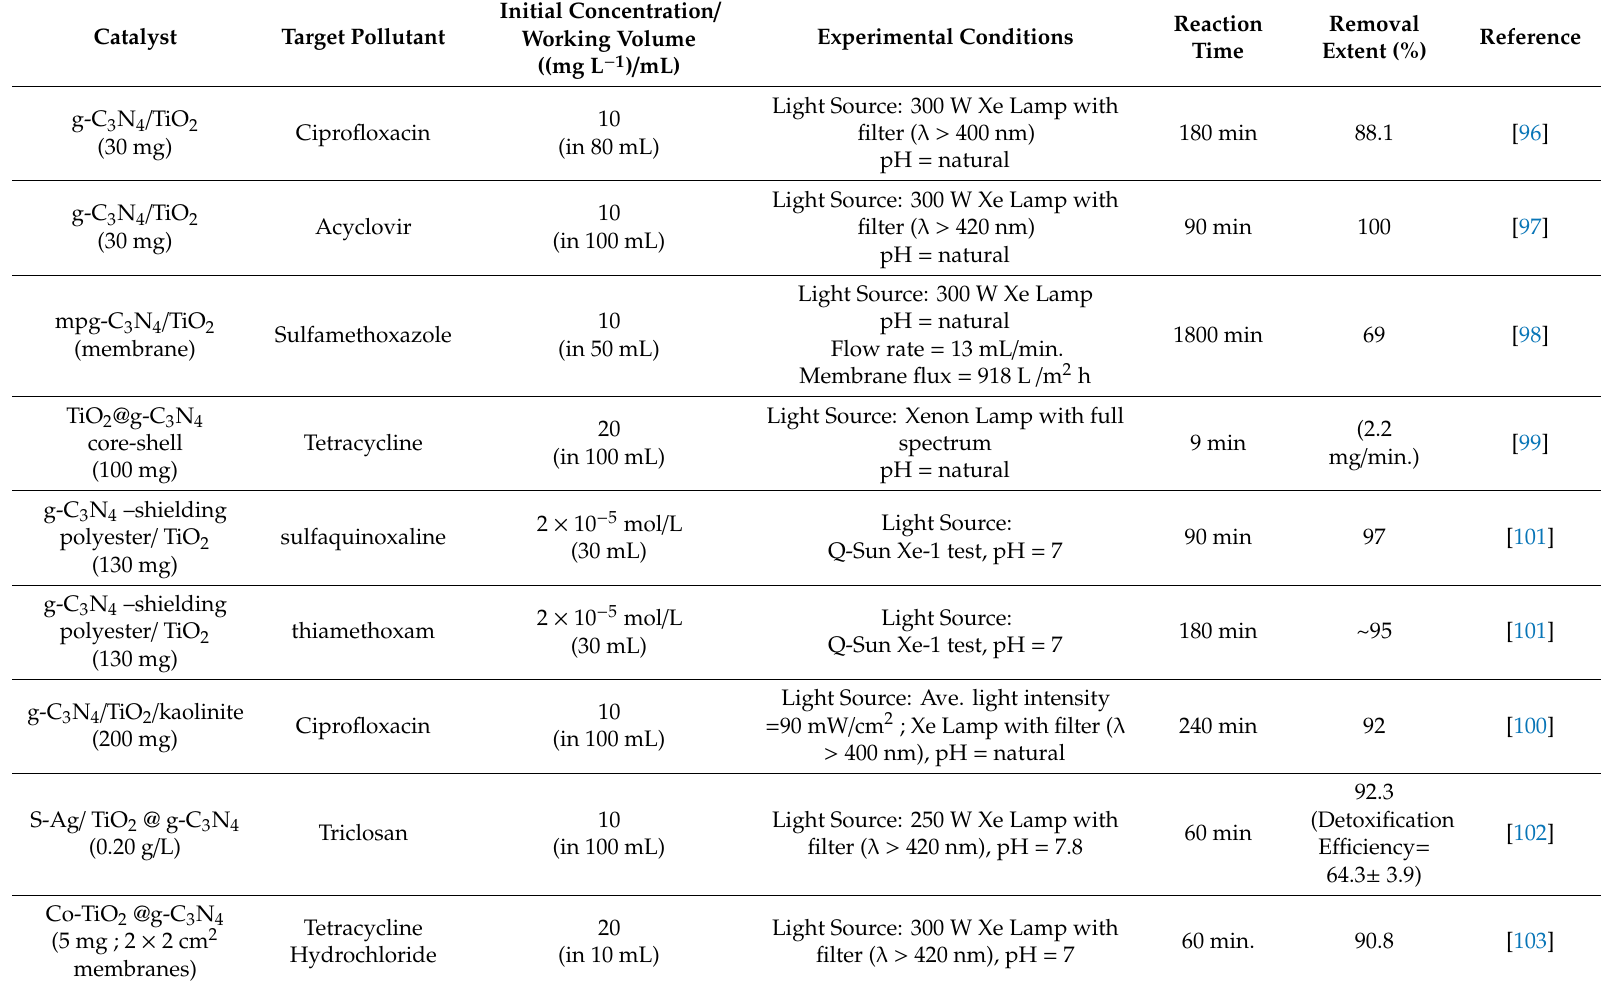
Table 9. Photocatalytic degradation of CEC’s over TiO 2 / g-C 3 N 4